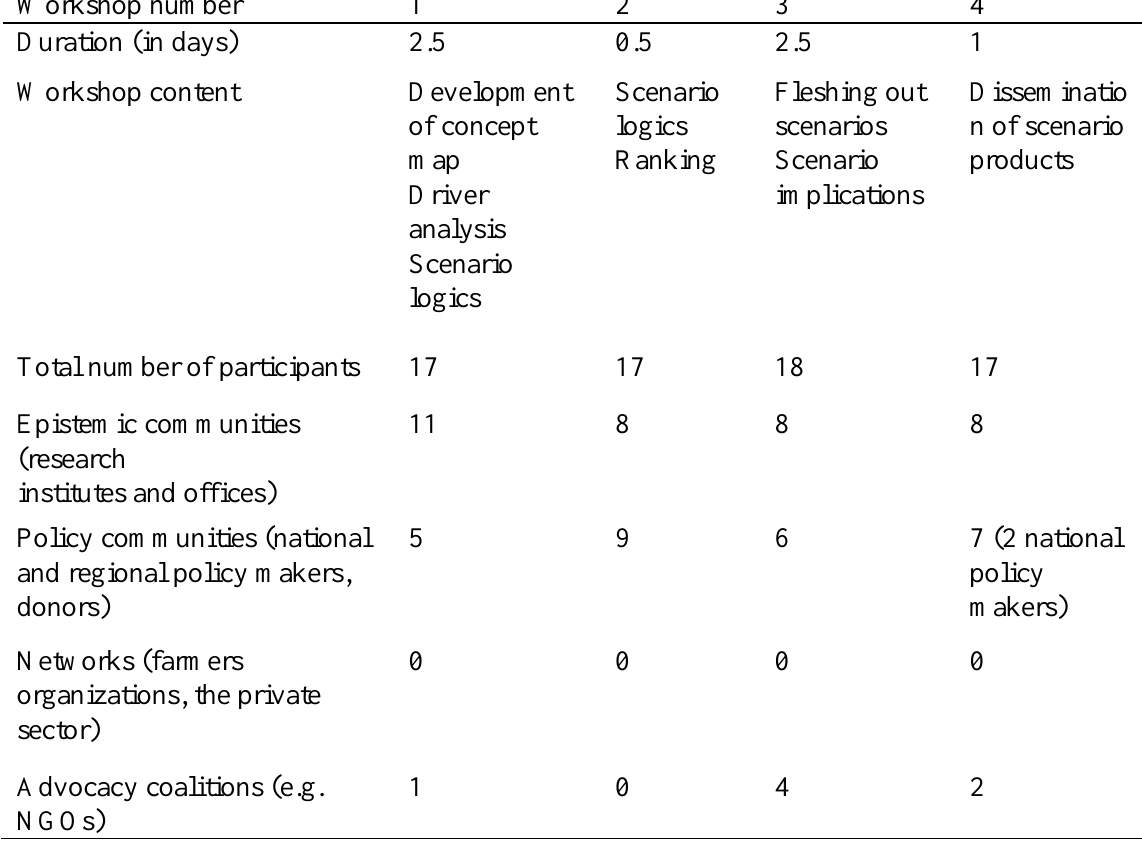
Table A1.2: Overview of the workshops undertaken in the Oum Zessar watershed organised by the Institut des Régions Arides, Observatoire du Sahara et du Sahel and Potsdam Institute